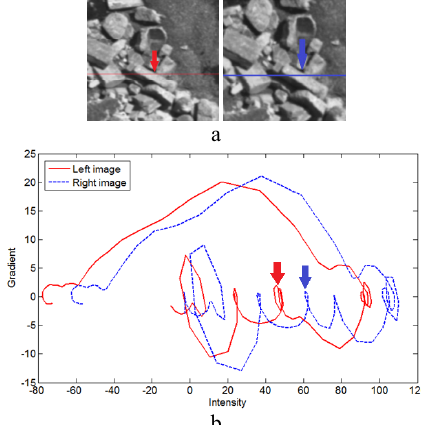
Figure 9. Representation of intrinsic curves, a) left and right rectified images, b) intrinsic curves in the space of intensity Assumption: Assume a pixel at location l x on the left scan-line i whose corresponding point on the right scan-line is located